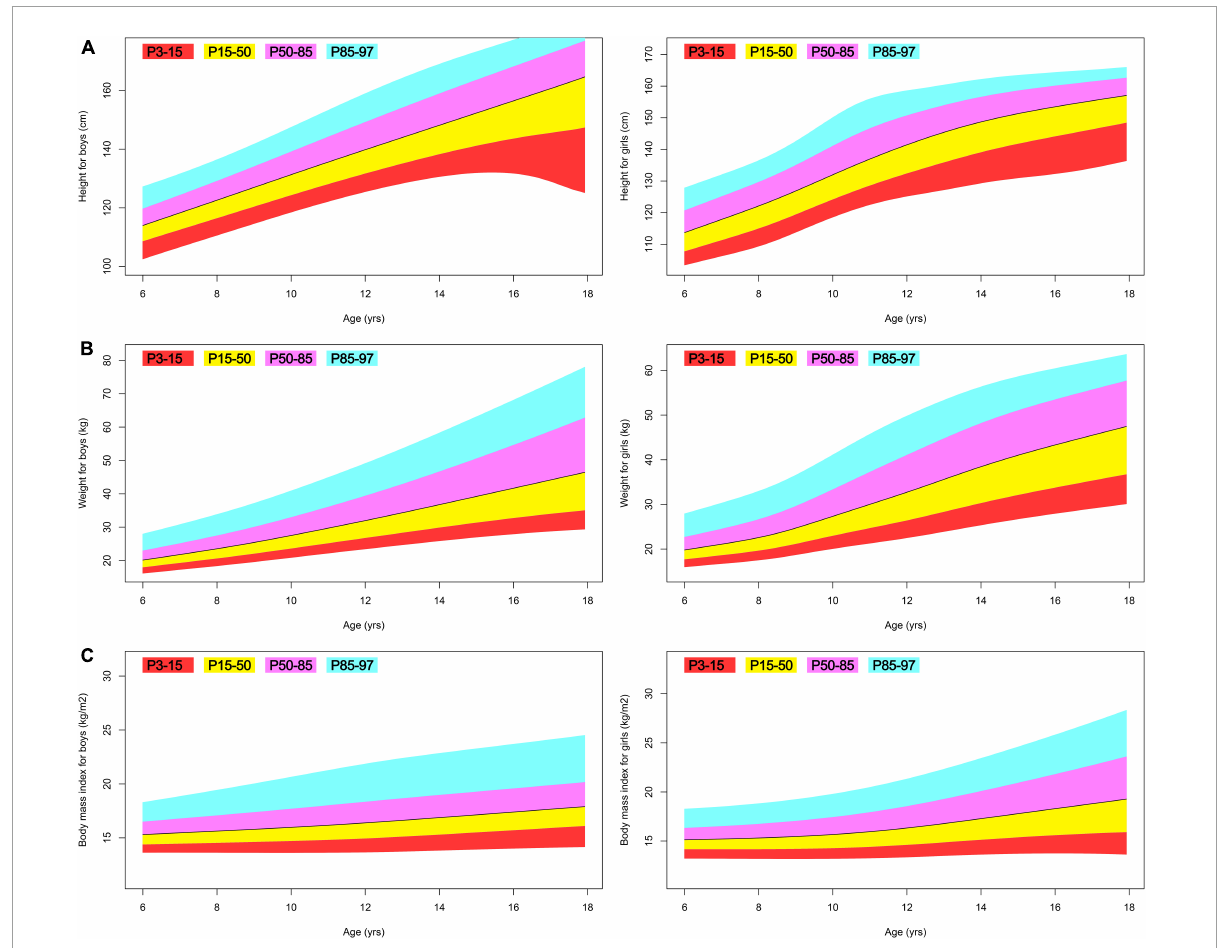
FIGURE3 Fan plot displaying the 3, 15, 50, 85, and 97% centiles for the anthropometric indices of Tibetan ethnic children aged 6–17. (A) Height; (B) weight; (C) body mass